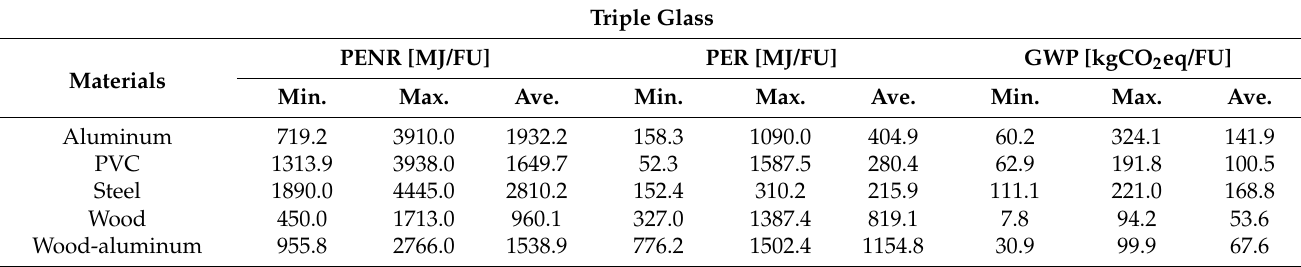
Table 7. Minimum, maximum and average values for PENR, PER and GWP of the triple-glazed windows analyzed according to the different frame